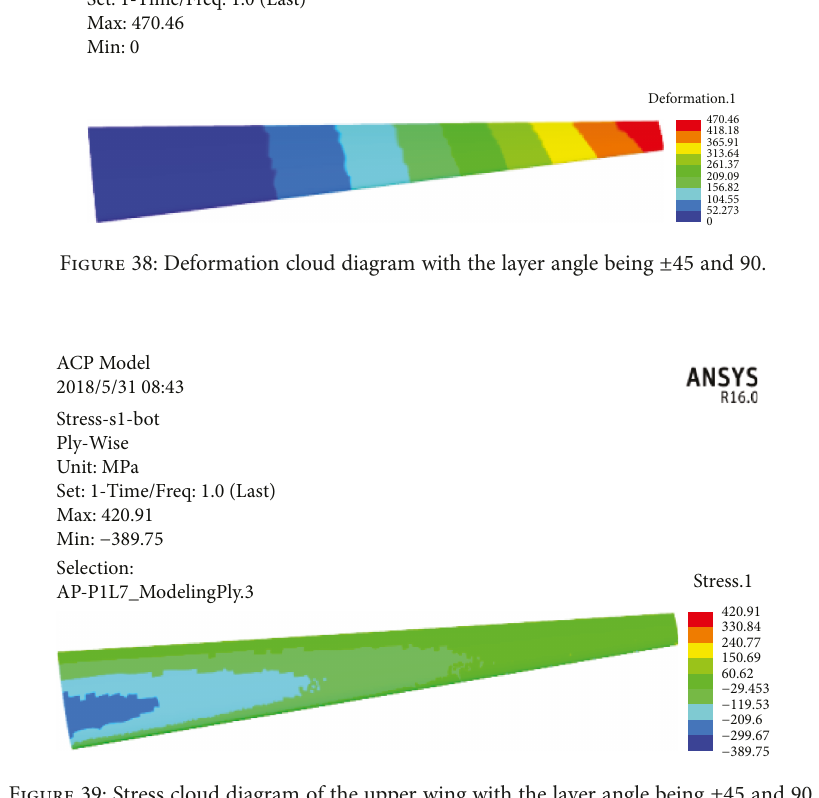
Figure 39: Stress cloud diagram of the upper wing with the layer angle being ± 45 and